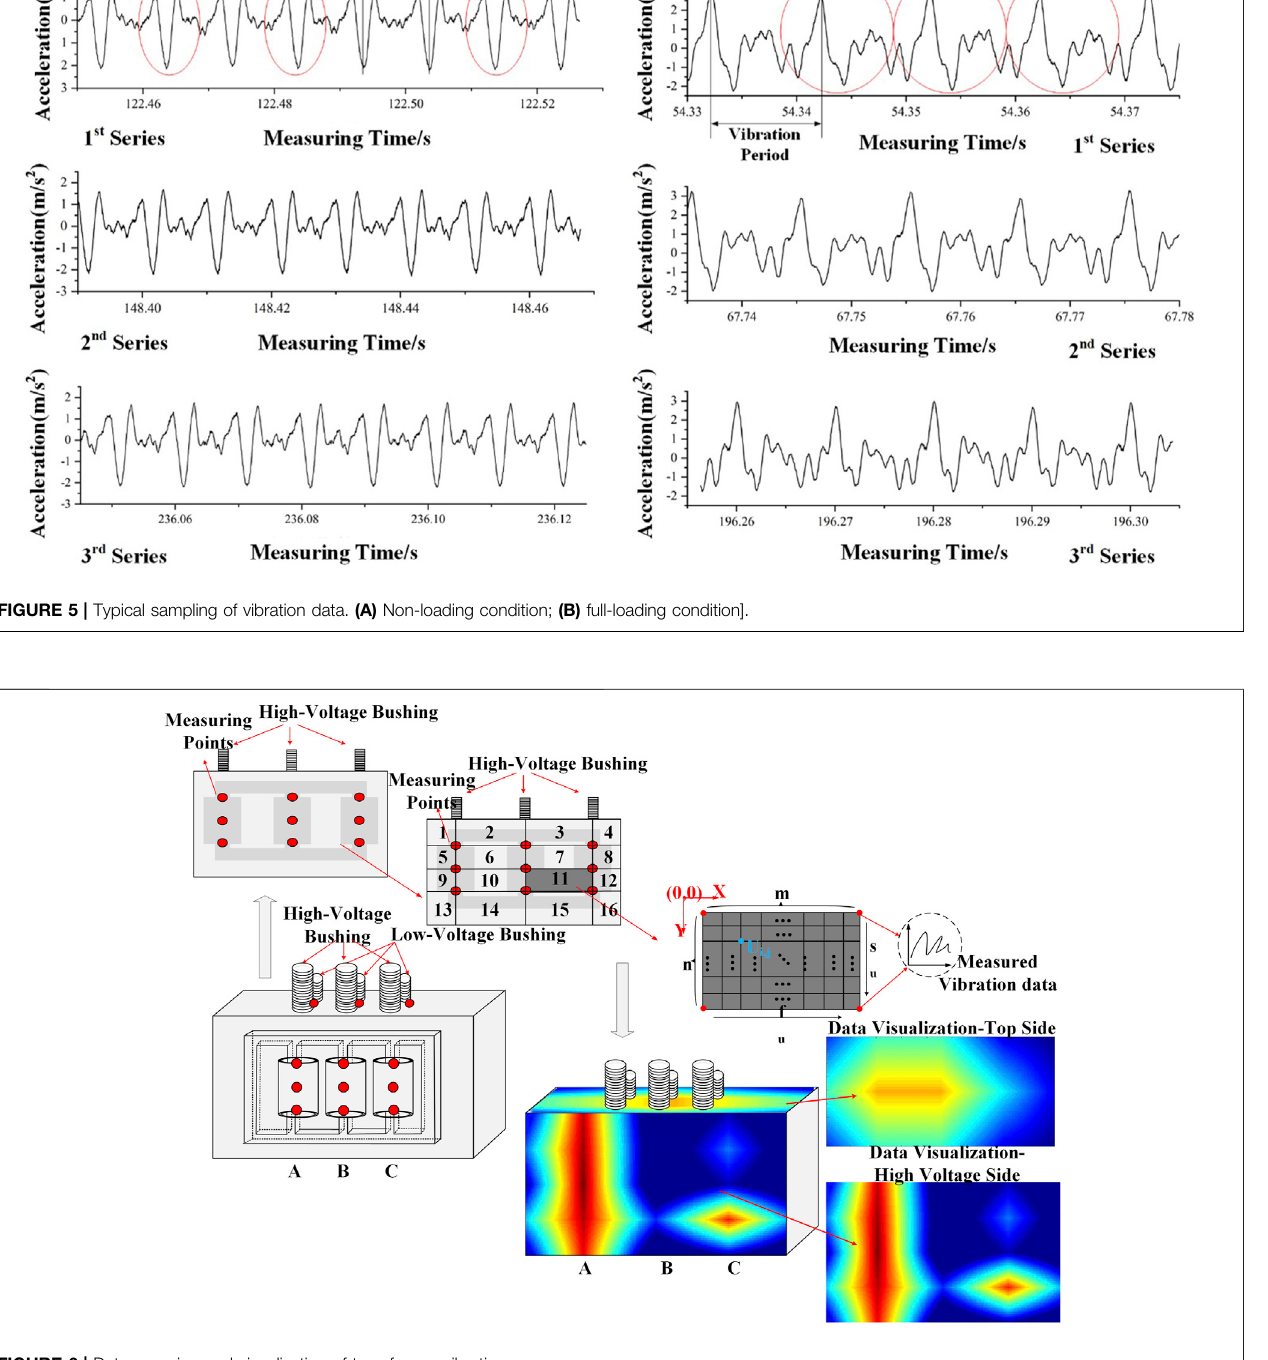
Frontiers in Energy Research |